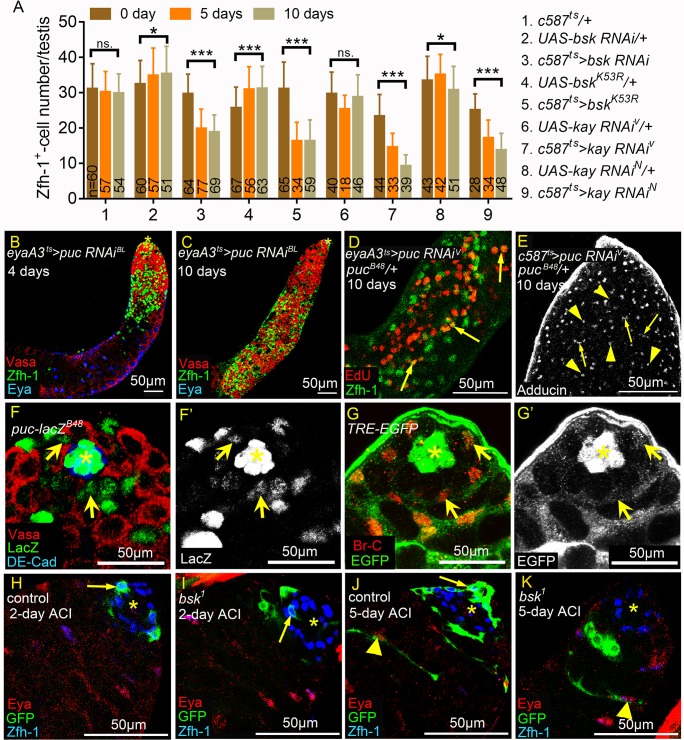
JNK signaling is required to maintain CySCs and early cyst cells.(A) Averages of Zfh-1-postive cell numbers per testis from unmated males at 0-, 5-, and 10-day-old. Numbers of testes scored are shown at the bottom of each column. Error bars represente SD. (B-E) puc knockdown testes. Animals were maintained at 25°C during development. (B and C) Testes immunostained for Zfh-1 (green), co-stained for Vasa (red) and Eya (blue). Testes were from males shifted from 25°C to 29°C for 4 days (B) or 10 days (C). 10-day incubation at 29°C led to excessive accumulation of Zfh-1-positive cells and small germ cells (C). (D) Testis labeled for EdU (red) incorporation and co-stained for Zfh-1 (green). Arrows mark Zfh-1 and EdU double-positive cells away from the hub, suggesting S phase progression in ectopic Zfh-1-positive cells. (E) Testis immunostained for Adducin to label spectrosomes (arrowheads) and thin fusomes (arrows). Numerous spectrosome-positive GSC/Gb-like cells and thin fusome-positive spermatogonia were observed in puc knockdown testes. (F-G’) Testes from 1w-old puc-lacZB48 (F and F’) and TRE-EGFP (G and G’) males. (F and F’) Testis immunostained for β-Galactosidase (green in F and white in F’), co-stained for DE-cad (blue) and Vasa (red). LacZ was detected in nucleus of CySCs (arrows). (G and G’) Testis immunostained for GFP (green in G and white in G’), co-stained for Br-C (red) to mark CySCs and early cyst cells. GFP was detected in nucleus and cytoplasm of CySCs (arrows). (H-K) Testes with control or bsk1 clones marked by MARCM system. Asterisks indicate the hubs. Arrows indicate the GFP-positive CySC clones. Arrowheads mark the cyst cells with elongated cytoplasmic GFP. Scale bars = 50μm. (H and I) When dissected 2 days after clone induction (ACI), CySC clones (arrows) were observed in both FRT40A control (H) and FRT40A
bsk1/+ (I) testes. (J and K) When dissected 5 days ACI, cyst cell clones with elongated cytoplasm (arrowheads) were observed in both FRT40A control (J) and FRT40A
bsk1/+ (K) testes. CySC clones were lost in some FRT40A
bsk1/+ testes (K). P-values were calculated with student t test in A. ns: p>0.05, *p<0.05, and ***p<0.001.